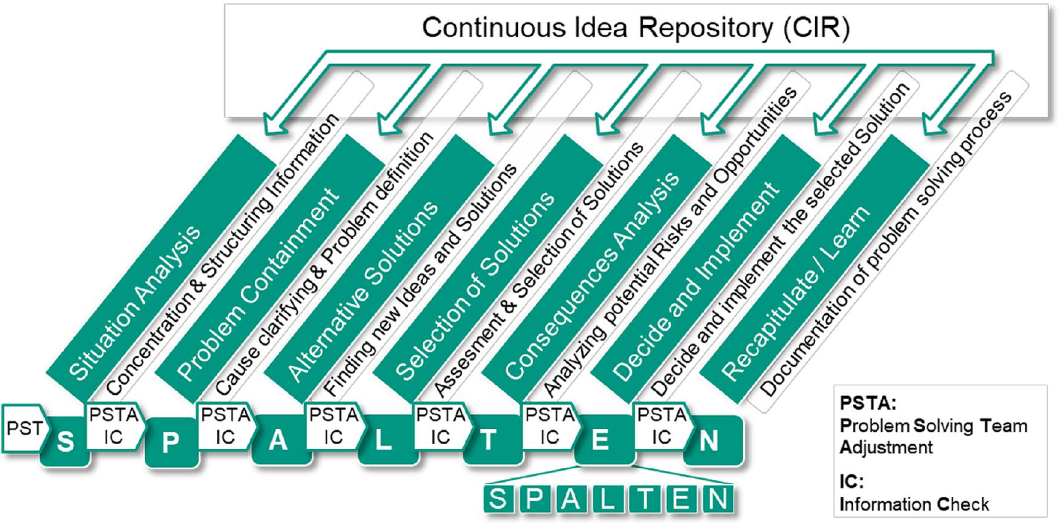
Fig. 2 The SPALTEN problem solving process according to